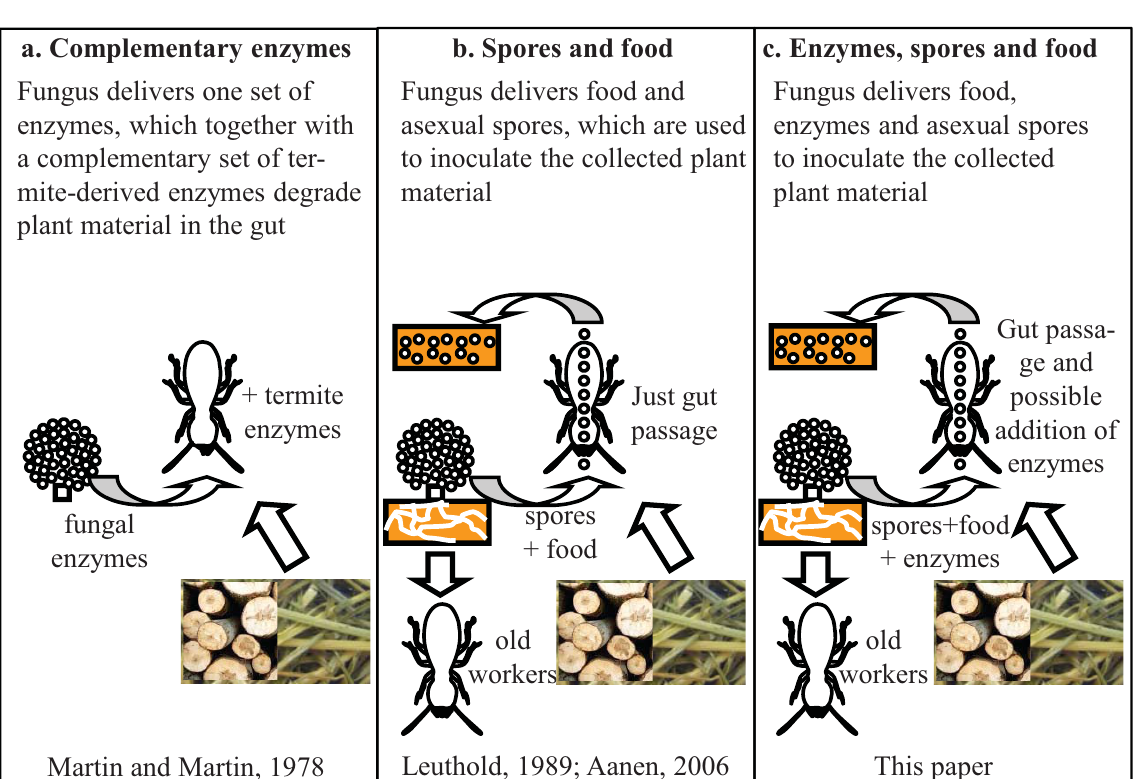
Figure 3. Alternative hypotheses for the role of the fungus as a source of food, spores and enzymes. ( a ) According to the acquired enzyme hypothesis, fungi and termites deliver different sets of cellulolytic enzymes, which together degrade the plant material inside the gut; ( b ) Nodules are an additional protein-rich food source and are used to inoculate the fungus garden; ( c ) the ruminant hypothesis—here raised—where nodules are a source of food, enzymes and spores. The fungi may deliver the complete set of (ligno)cellulolytic enzymes, or the fungi and termites deliver different, complementary